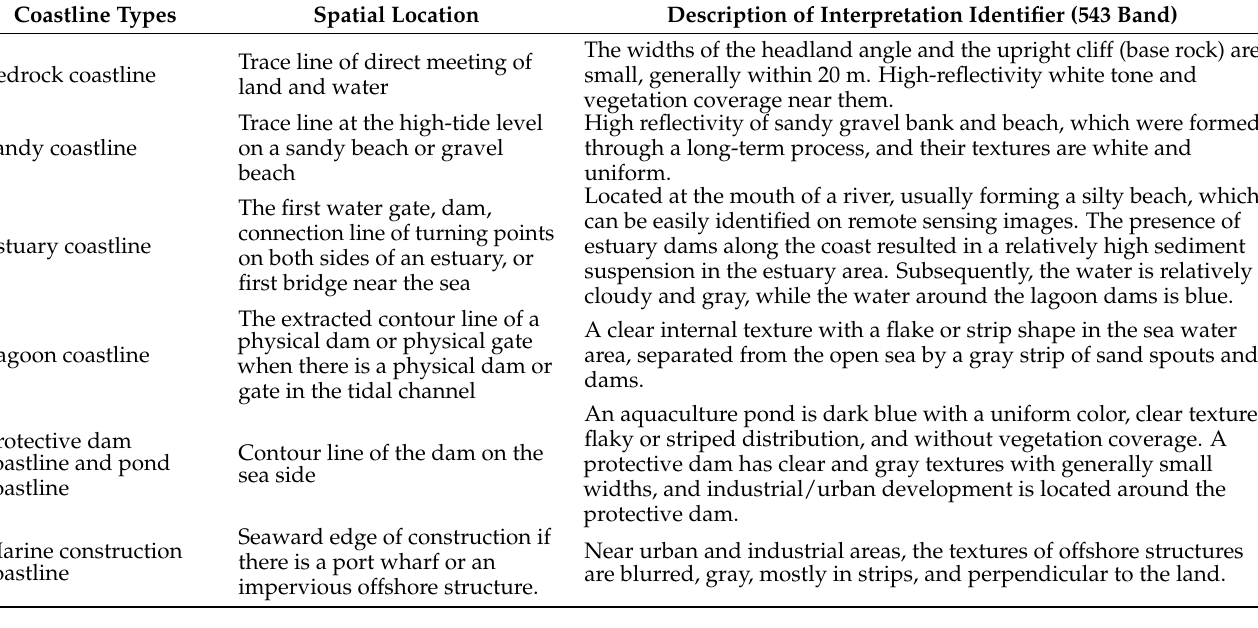
Table 2. Coastline types and interpretation rules in the